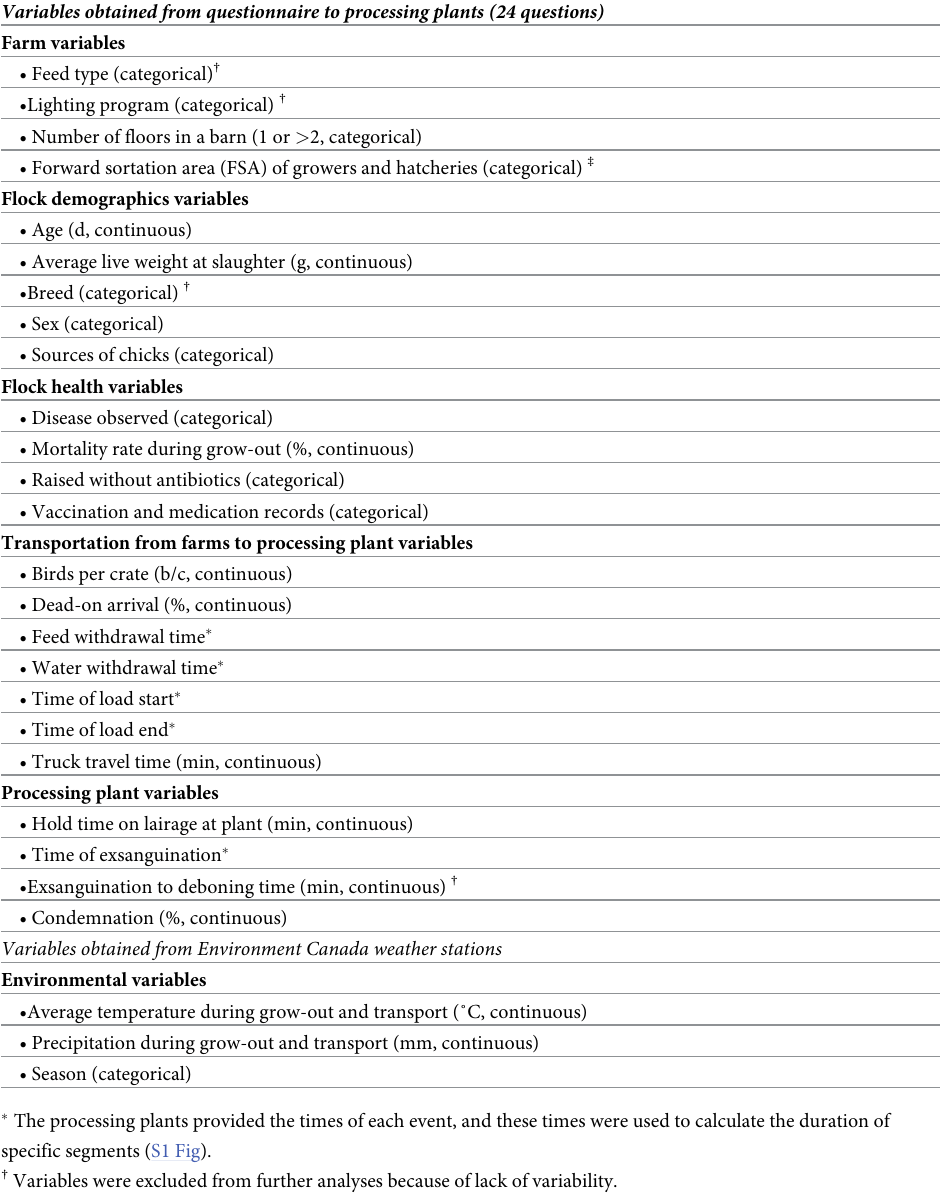
Table 1. Summary of data collected from the questionnaire and Environment Canada weather stations for the analysis of the occurrence of breast myopathies. Variables obtained from questionnaire to processing plants (24